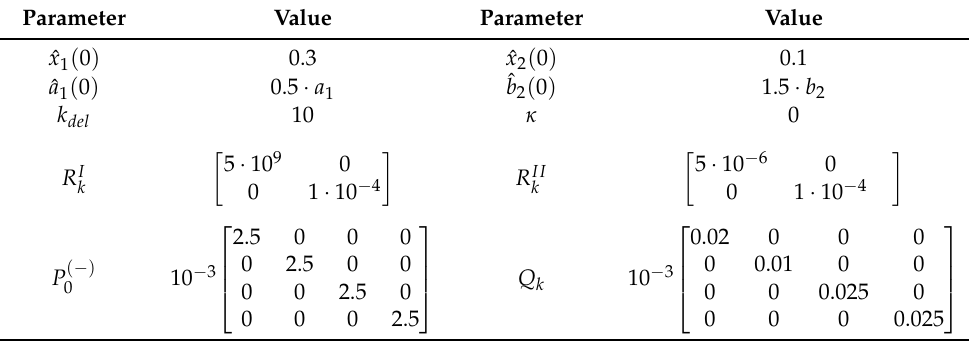
Table 3. Parameters and initial conditions for exothermic reactor scenario II.